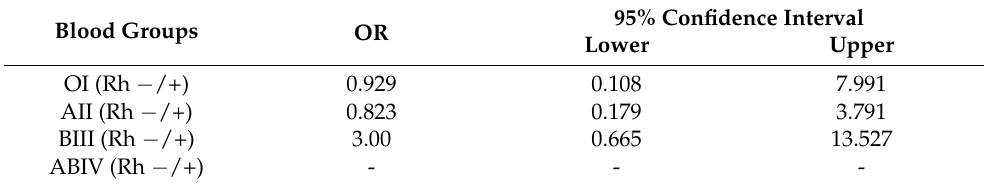
Table 5. Risk estimate for the different ABO and Rh blood groups